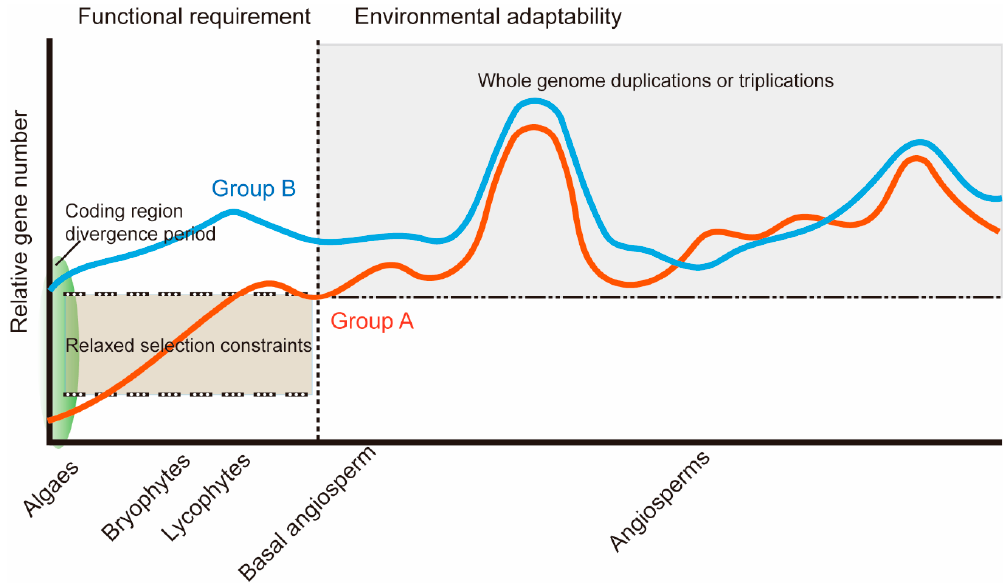
Figure 7. Proposed evolutionary model of aldo-keto reductases ( AKR ) genes in the plant kingdom. The orange line represents group A AKR genes, and the blue line represents group B AKR genes. The green oval represents the AKR gene coding region divergence period.